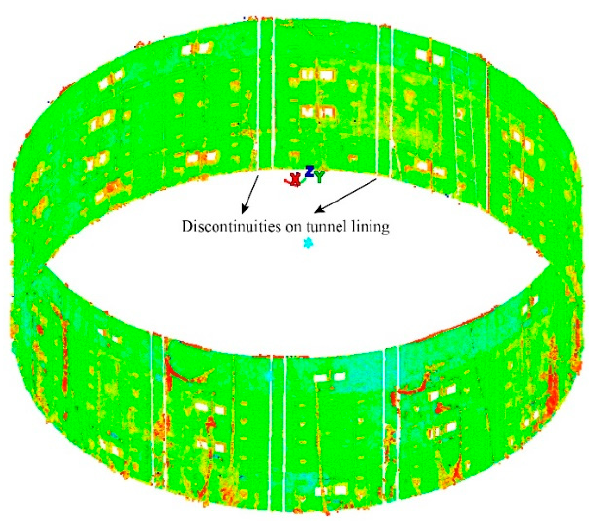
Figure 4. The pre-processed point cloud data of a sub-rectangular tunnel lining.